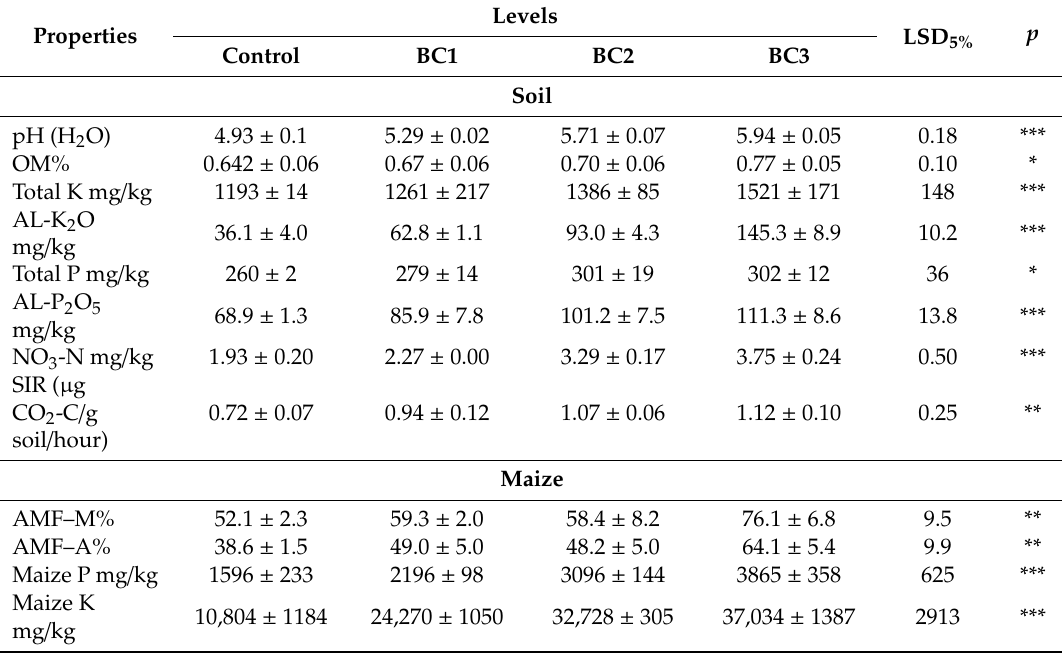
Table 3. Significant e ff ect of individual biochar (BC) treatment levels (% w / w ) on the properties of acidic sandy soil and maize. Data are mean ± sd of the replicates.